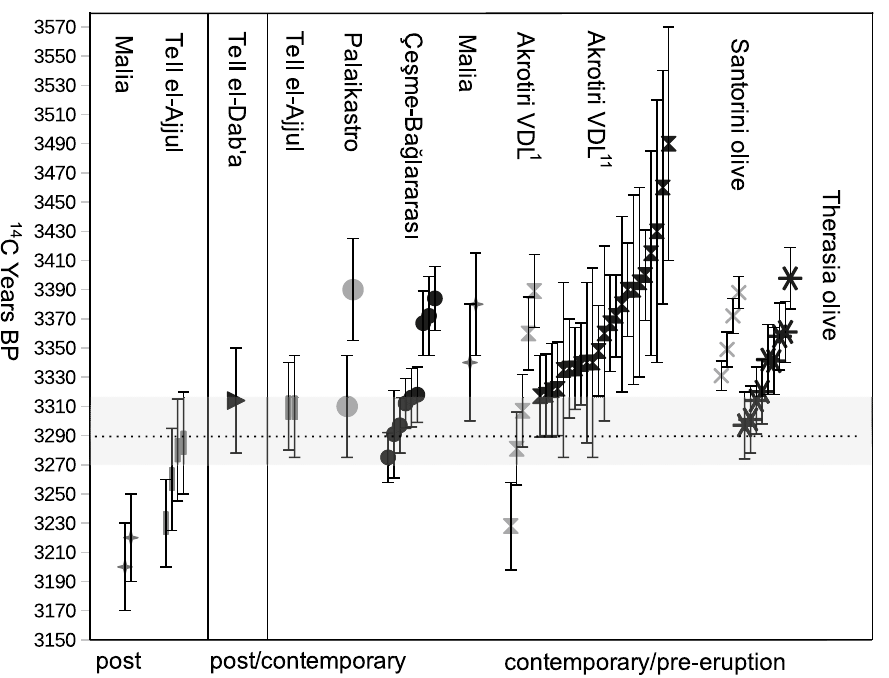
14 Figure 3. The youngest C measurement from the Therasia olive (dotted horizontal line) with stated errors (grey horizontal band) relative to other uncalibrated dates from secure pre- and post-Thera eruption contexts. From left to right: Post-tsunami stratigraphy, Malia, Crete 36 ; after pumice arrives at Tell el-Ajjul 37 ; after